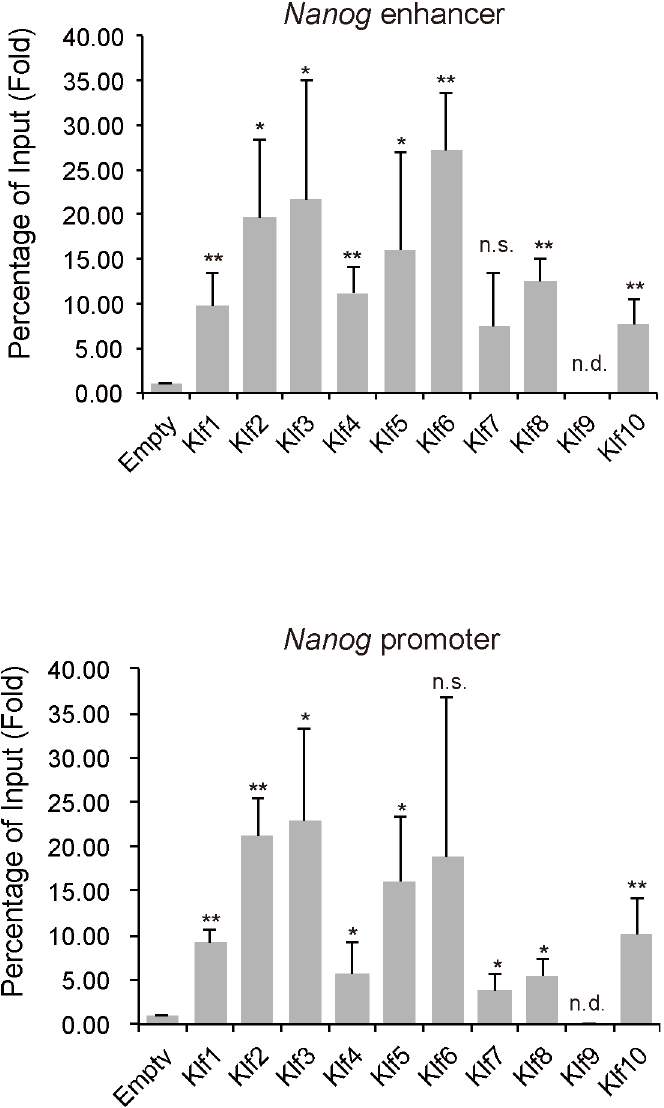
Fig 6. ChIP analysis of the binding of Klf to Nanog regulatory regions in mouse EpiSCs. ChIP experiments were performed with an anti-FLAG antibody to identify the promoter and enhancer of Nanog . Asterisks indicate statistical significance. * P < 0.05; ** P < 0.01; n.s.; not significant; n.d.; not